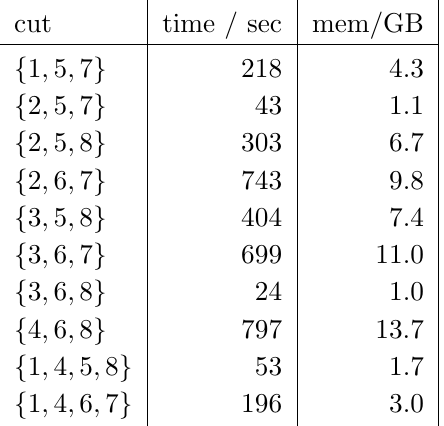
Table 2 . Timings and RAM usages for the module intersection computations for the relevant cuts of the non-planar hexagon-box